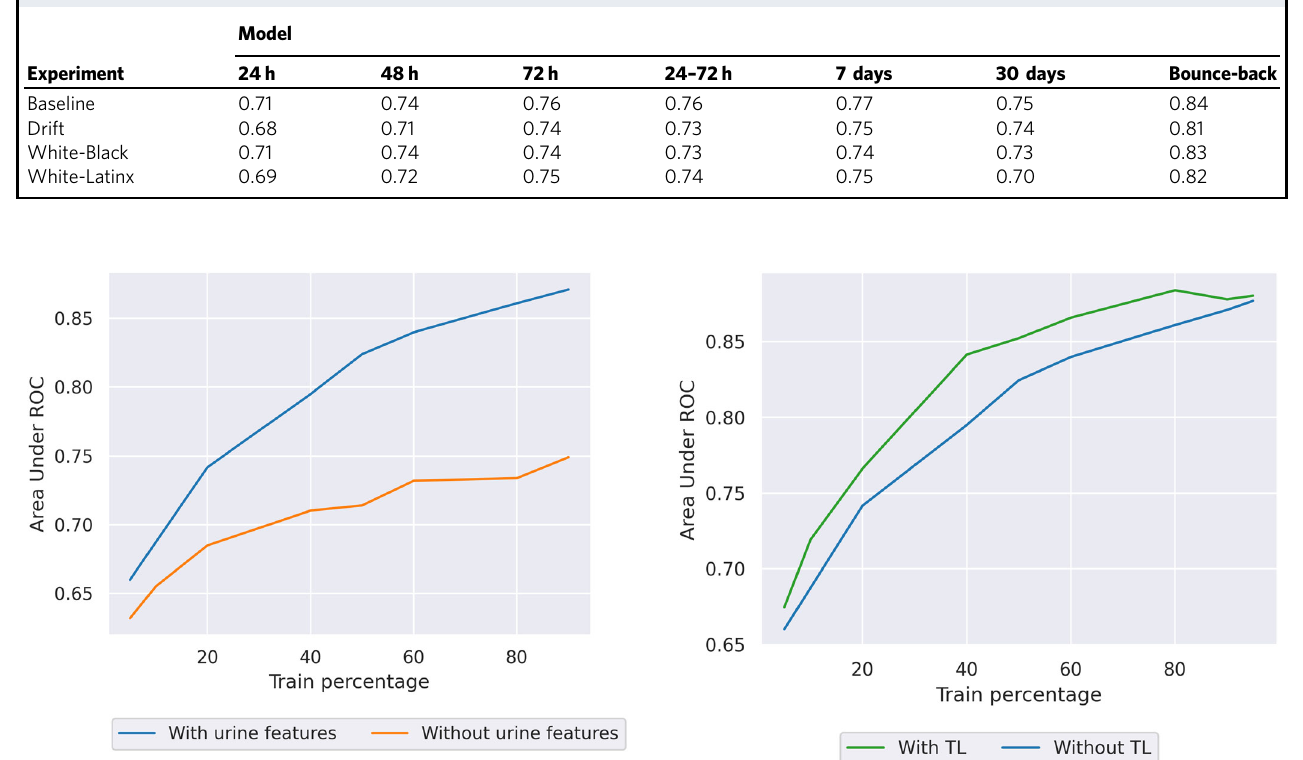
Scenario 4: Change of population . The results in Table 5 show the impact in terms of AUROC performance for the AKI model.